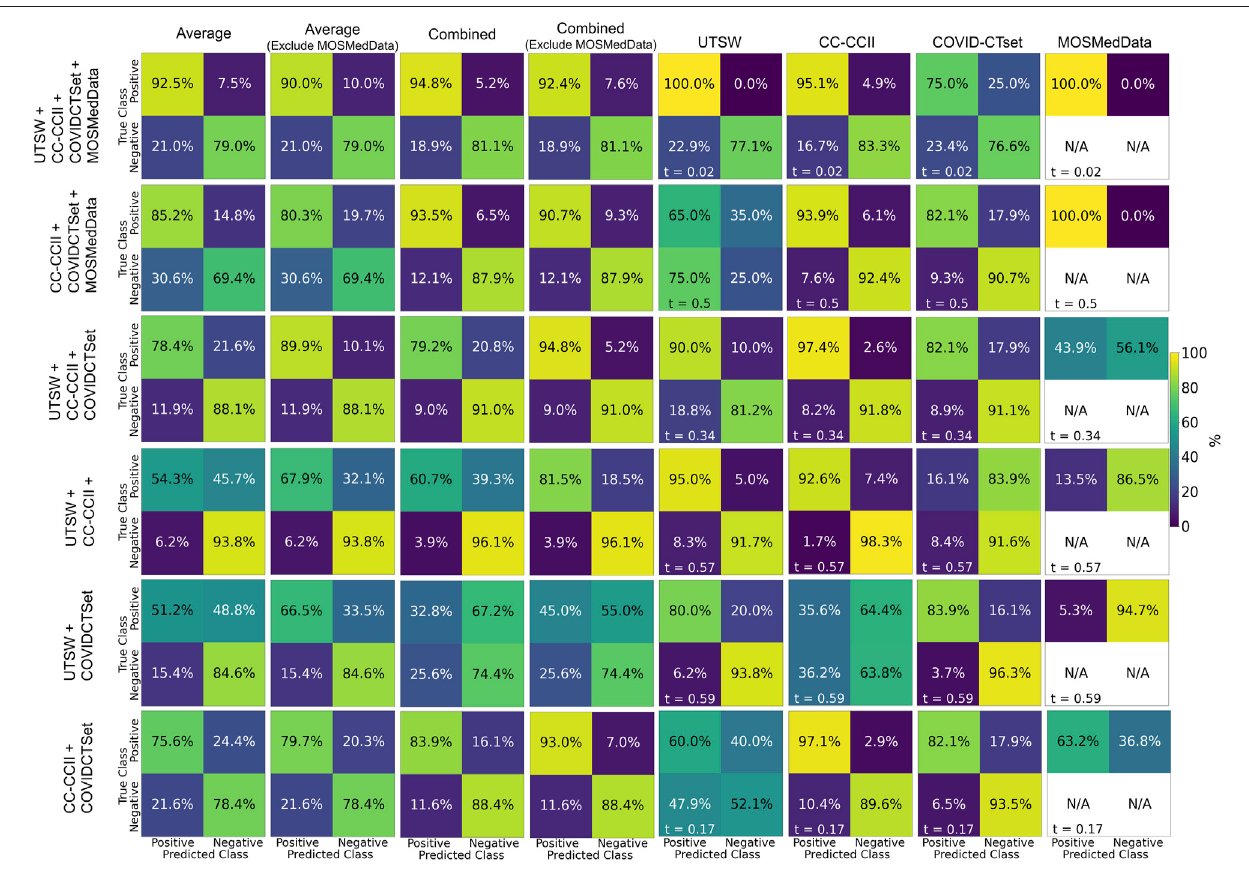
FIGURE 4 | Confusion matrices on the test data for each of the models trained on multiple datasets. Each row represents the datasets that the model was trained on,andeachcolumnrepresentsthedatasetsthatthemodelwasevaluatedon.Thelabelingthresholdusedforeachmodelisindicatedonthelowerleftofeachconfusion matrix ( t (cid:2) #). The “ Average ” confusion matrix isan equally weighted average among each dataset,whilethe “ Combined ” confusion matrixis calculated from all samples from the